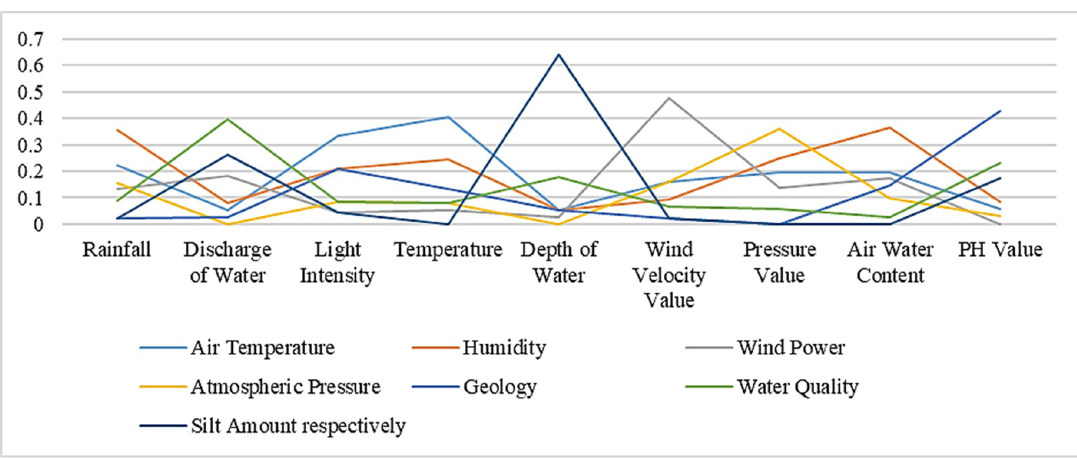
Figure 2. Similarity results based on instance strategy. Table 6. Similarity results based on semantic strategy.